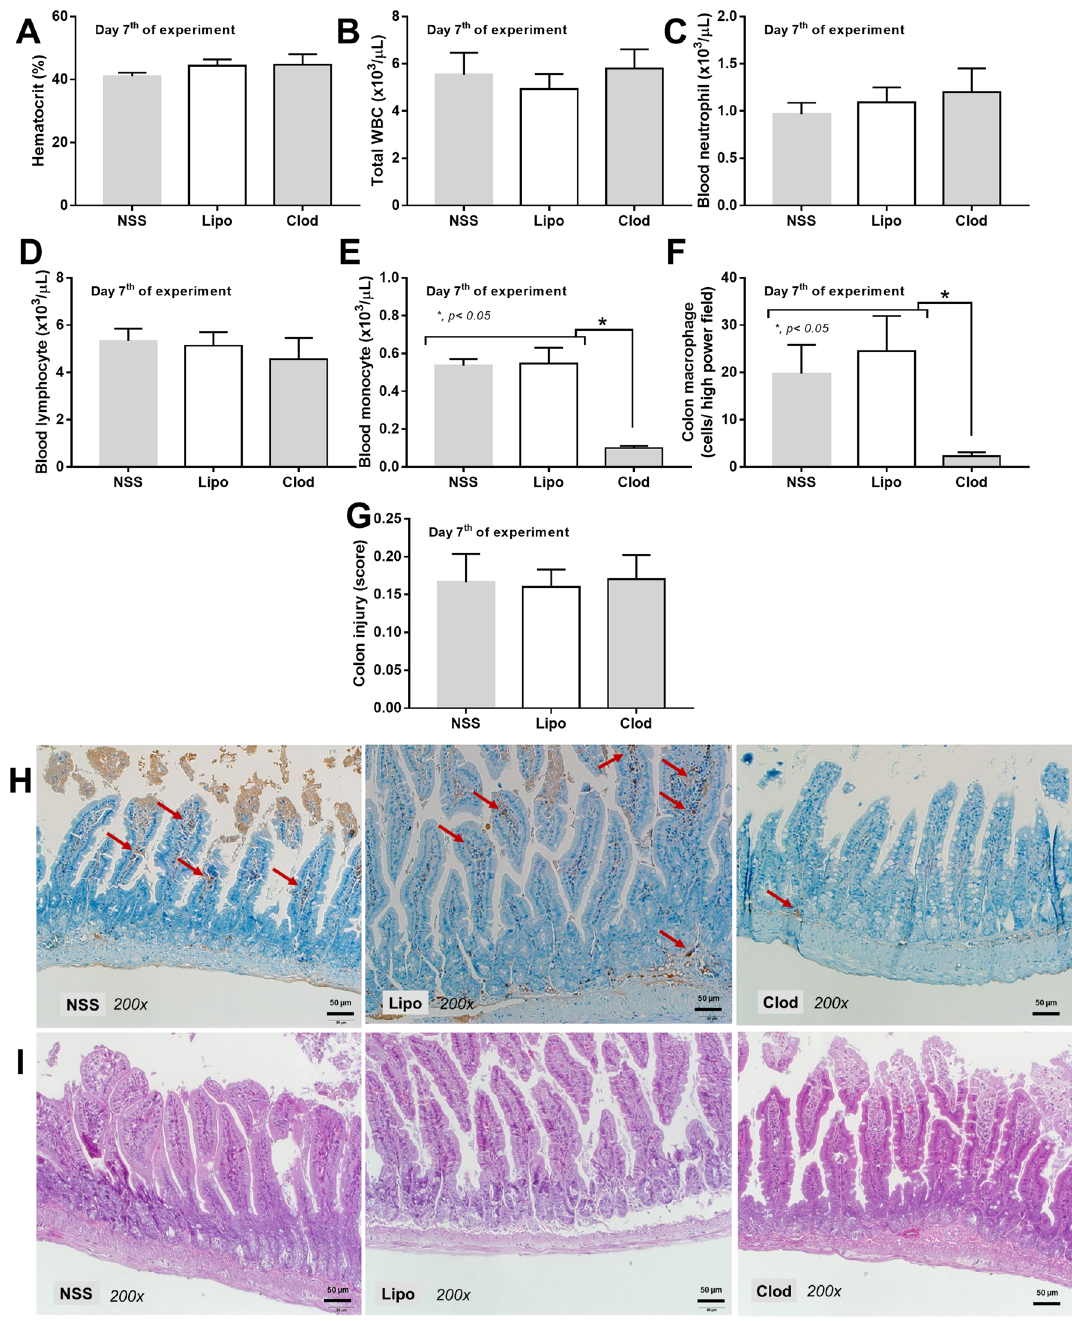
Figure 1. Characteristics of mice with the intraperitoneal administration by normal saline (NSS), liposome control (Lipo), or liposomal clodronate (Clod) as indicated by hematocrit and peripheral blood leukocytes, including total white blood cells (WBC), neutrophils, lymphocytes, and monocytes ( A – E ), macrophages in the colon (positive F4/80 cells from immunohistochemistry analysis) ( F ), colon injury score ( G ), and representative pictures of colons with immunohistochemistry and Hematoxylin and Eosin ( H , E ) stained slides ( H , I ) are demonstrated (n = 5–7/group). Arrows indicate F4/80 positive cells in the formed in macrophage-depleted mouse feces. With macrophage depletion (non-sepsis), fecal fungi in Asco- mycota, Debaryomyces, and Myrothecium together with the beta diversity (Bray–Curtis) (Fig. 2A–F), alpha diversity (Shannon and Chao 1 analysis), and observed total operational taxonomic units (OTUs; cluster of similar sequence variants of the marker gene sequence) (Fig. 2G) were predominantly increased when com- pared with the liposome control group (Fig. 2A–G). Additionally, fecal fungi could be detected by culture only in feces of macrophage-depleted mice (Fig. 2H). These data supported the increased fecal fungal abundance (observed OTUs and fecal culture) (Fig. 2G, H), especially Ascomycota group (a group that including Candida